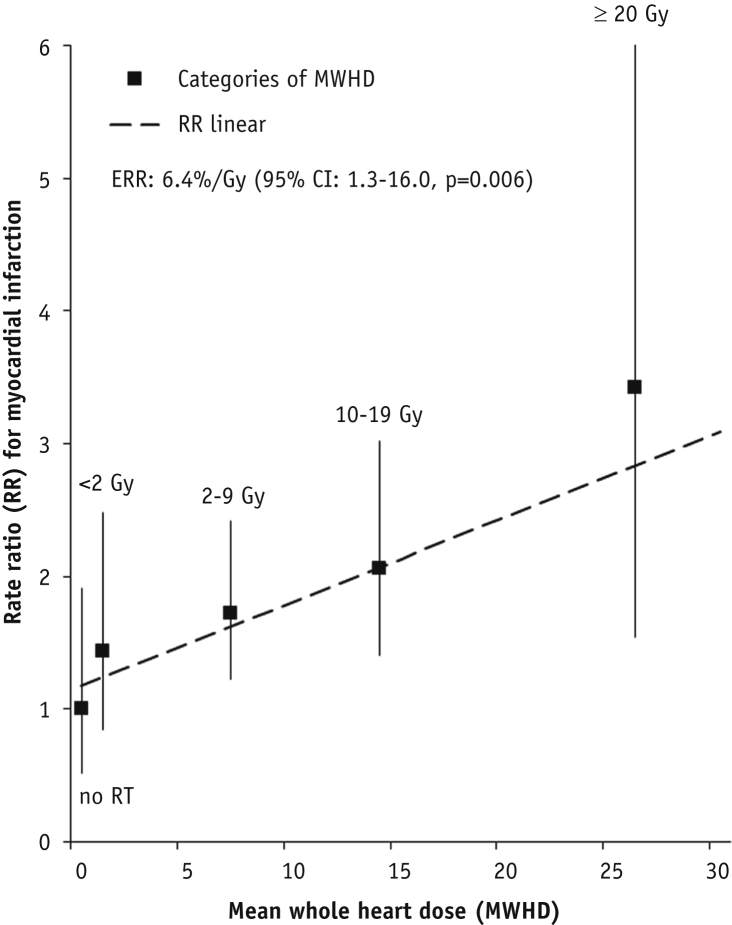
Dose-response relationship between rate of myocardial infarction and mean whole heart dose. The regression line is the best fitting linear dose response relationship (RR = κ[1.18 + 0.06389*MWHD]; P = .006). This results in an ERR of 6.4%/Gy (95% CI, 1.3-16.0). Squares indicate point estimates for dose categories (no RT, <2 Gy, 2-9 Gy, 10-19 Gy, ≥20 Gy; Table 2) and are plotted at the mean MWHD of each dose category. No significant departure from linearity was identified. The sum of the squared distances between the point estimates for dose categories was used to find the best fit of the linear dose-response to the categorical estimates, resulting in a linear RR of 1.18 at 0 Gy. Abbreviations: CI = confidence interval; ERR = excess rate ratio; MWHD = mean whole heart dose; RR = rate ratio; RT = radiation therapy.